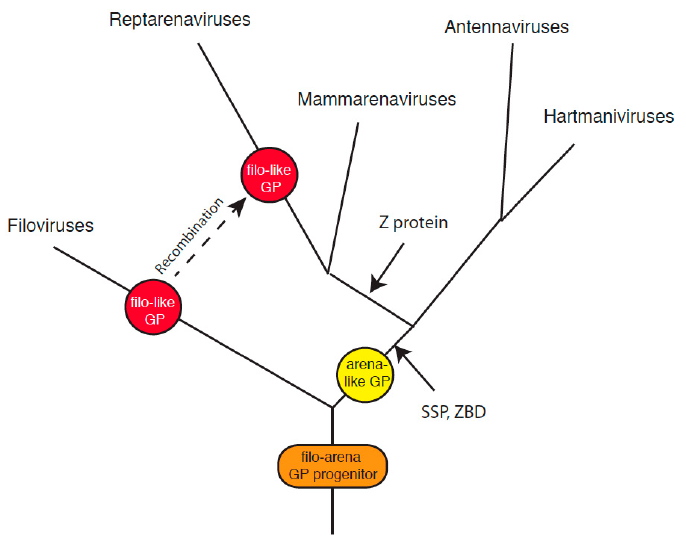
Figure 6. Possible evolution of the Arenaviridae . Members of the Arenaviridae and Filoviridae may have a common ancestor encoding the progenitor of arenavirus and filovirus glycoproteins. Acquisition of the stable signal peptide (SSP) and intracellular zinc-binding domain (ZBD) in the arenavirus glycoprotein complex (GPC) followed divergence from the filoviruses. Mammarenaviruses and reptarenaviruses acquired a zinc-binding protein (Z) following divergence from antennaviruses and hartmaniviruses. Reptarenaviruses then replaced the arenavirus GPC or a progenitor with a filovirus-like class I glycoprotein via recombination.